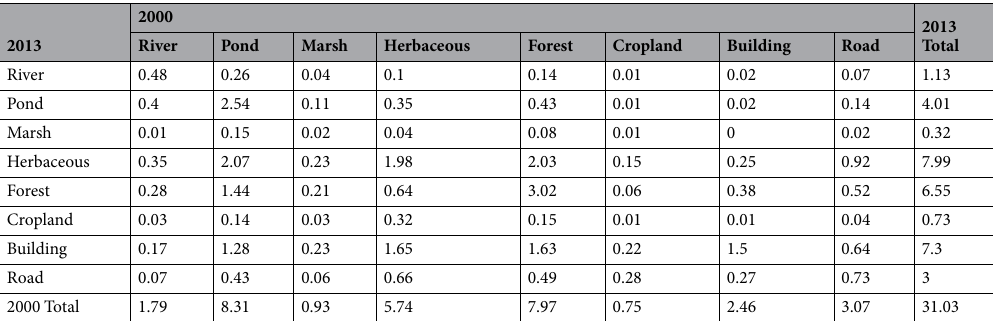
Table 4. Matrices of LULC and changes (km 2 ) from 2000 to